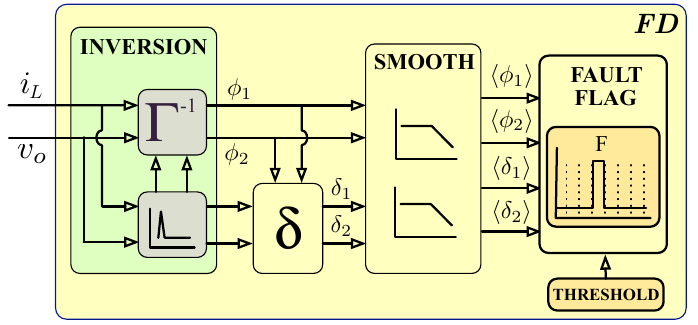
Figure 5. Overview of the implemented Fault Detection (FD) system.